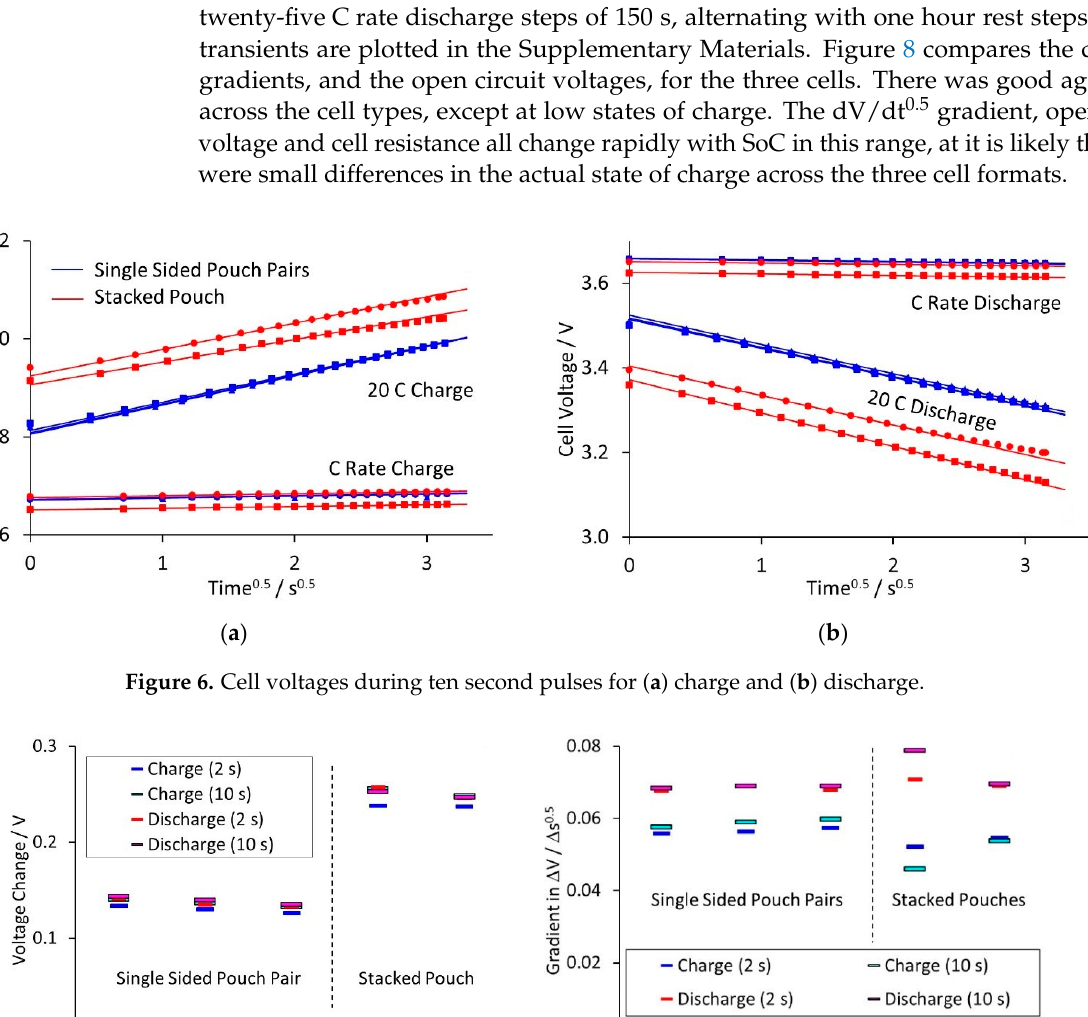
( b ) Figure 5. Discharge capacities at different rates for ( a ) single sided pair pouch and stacked pouch cells, and ( b ) coin cells. The anode half cell tests were complicated by the creation of internal short circuits; in many cases the delithiation capacity was much higher than the lithiation capacity. High rate delithation at the anode requires high-rate lithium deposition on the lithium metal, i.e., an increased risk of dendrite formation. The capacities were derived from the first